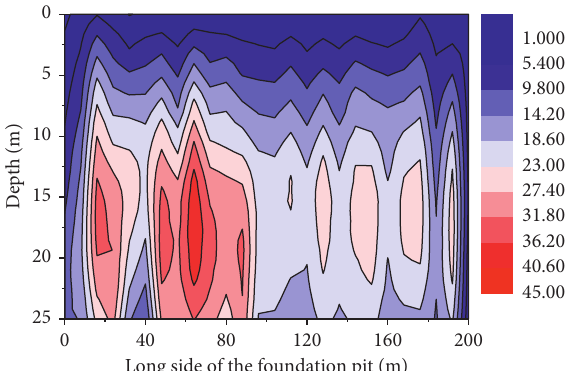
Figure 13: Lateral movement contour of the retaining structures after